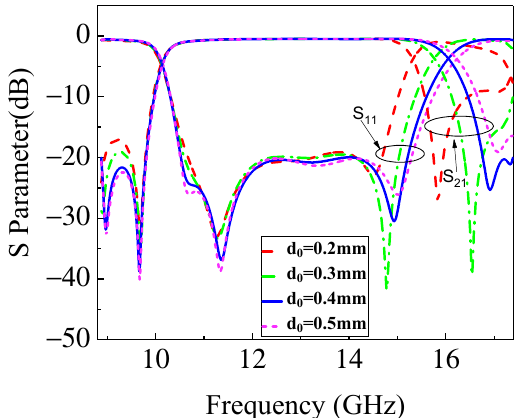
Figure 7. Simulation of S parameters when diameter d 0 of the blind hole is varied from 0.2 mm to 0.5 mm, with a step of 0.1 mm increment.